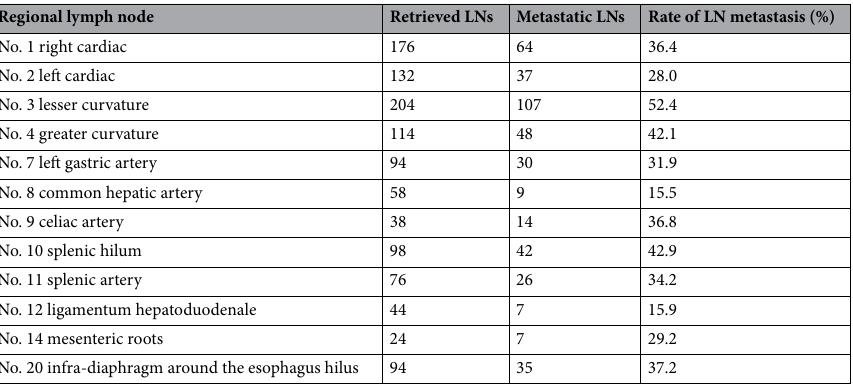
Table 5. Characteristic of lymph nodes